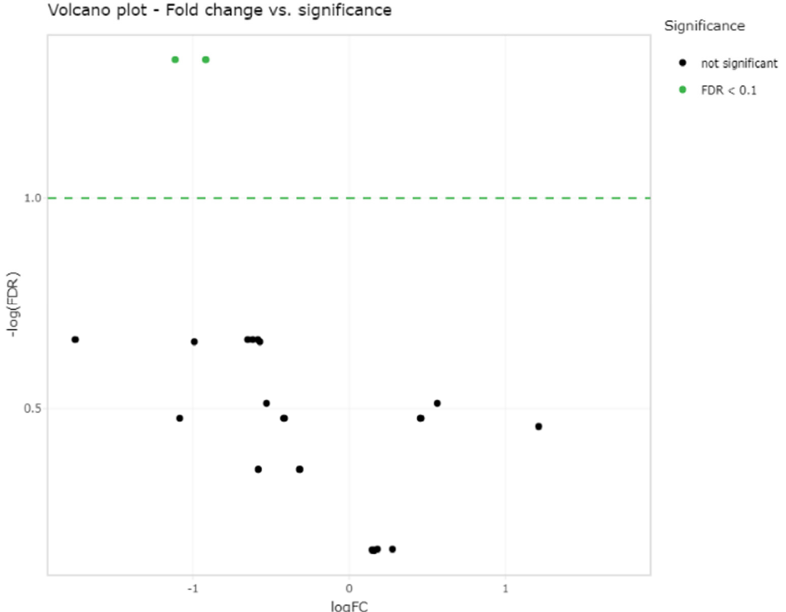
Figure 2. Volcano plot showing the relation of each miRNA logFC in the two groups and the statistical significance of this change (FDR < 0.1) which demonstrates three significantly differentially expressed miRNAs; miR-25, miR-16 and miR-92a (green dots) between the two groups (two green dots overlap (miR-16 and miR-92a)). Log fold change (LogFC) and false discovery rate (FDR).